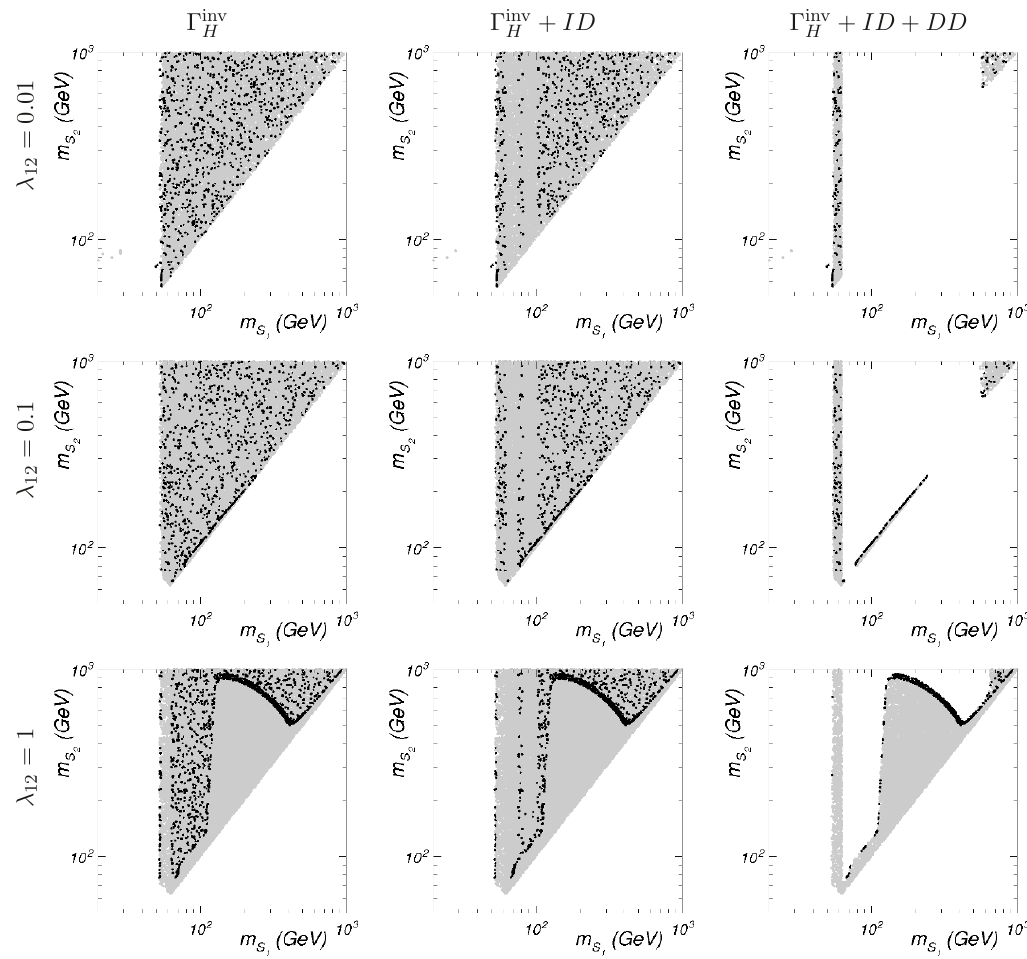
Figure 8 . Effect of the experimental constraints in the model. We have used the same examples and colour conventions as in figure